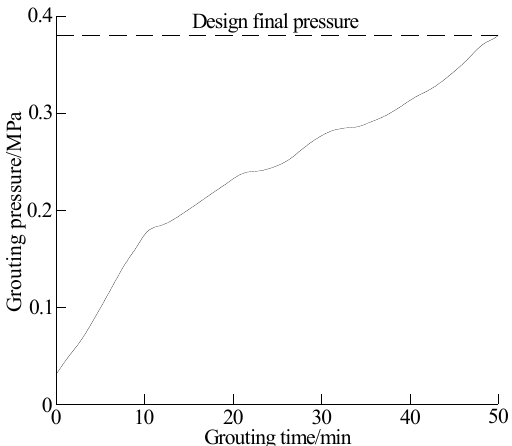
Figure 6. Relation between grouting pressure and time.